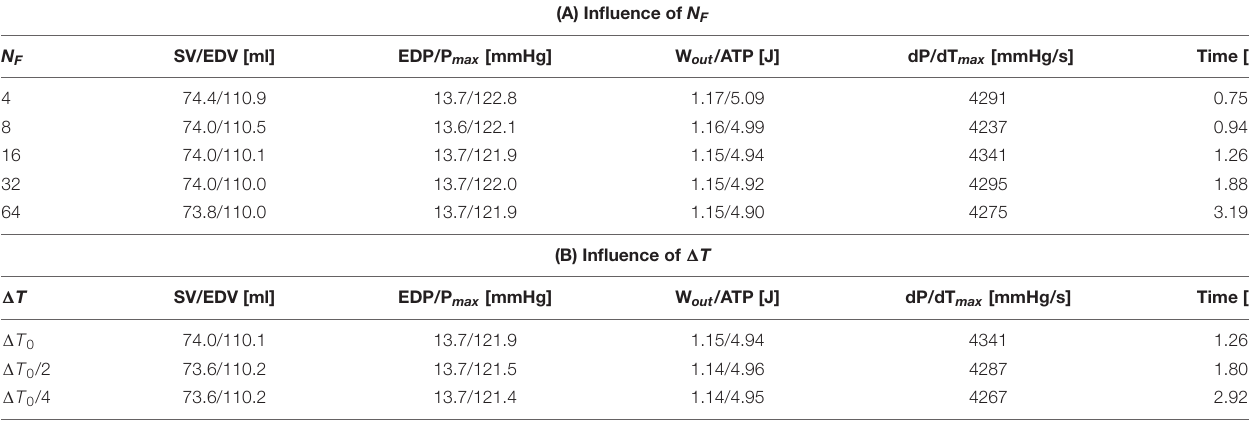
TABLE 1 | Influence of the filament number N F (A) and FE time step size (cid:49) T (B) on overall pumping performance and computational time. (A) Influence of N F